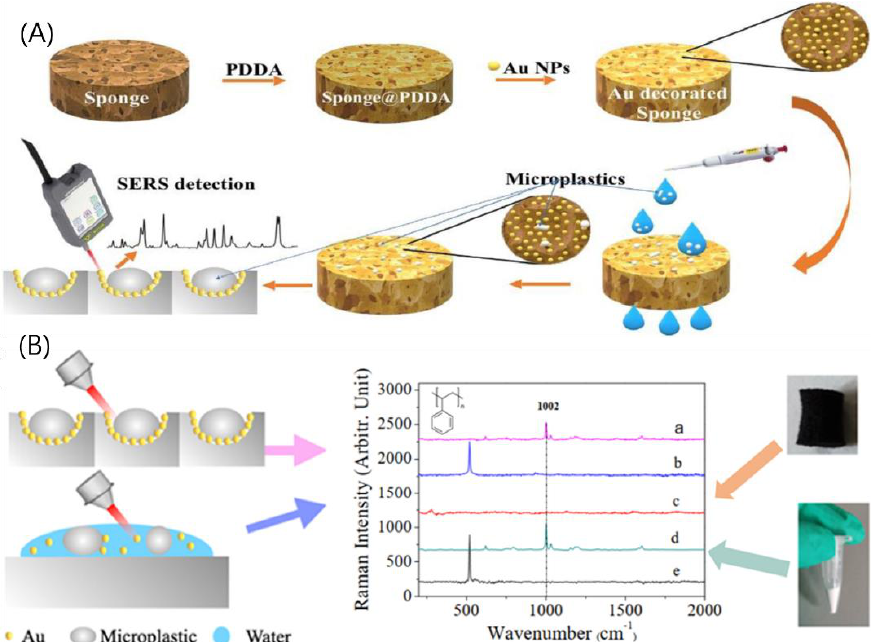
Figure 6. ( A ) A schematic of SERS detection of MNPs. ( B ) Measure the Raman spectra of polystyrene in the sponge-supported Au NPs and polystyrene miss Au colloid. Reprinted with permission [245], copyright 2021, Elsevier. Measure the Raman spectra of polystyrene in SA (a), polystyrene mis Au colloid (b), SA black (c), polystyrene solid (d) and Au solid (e) respectively.